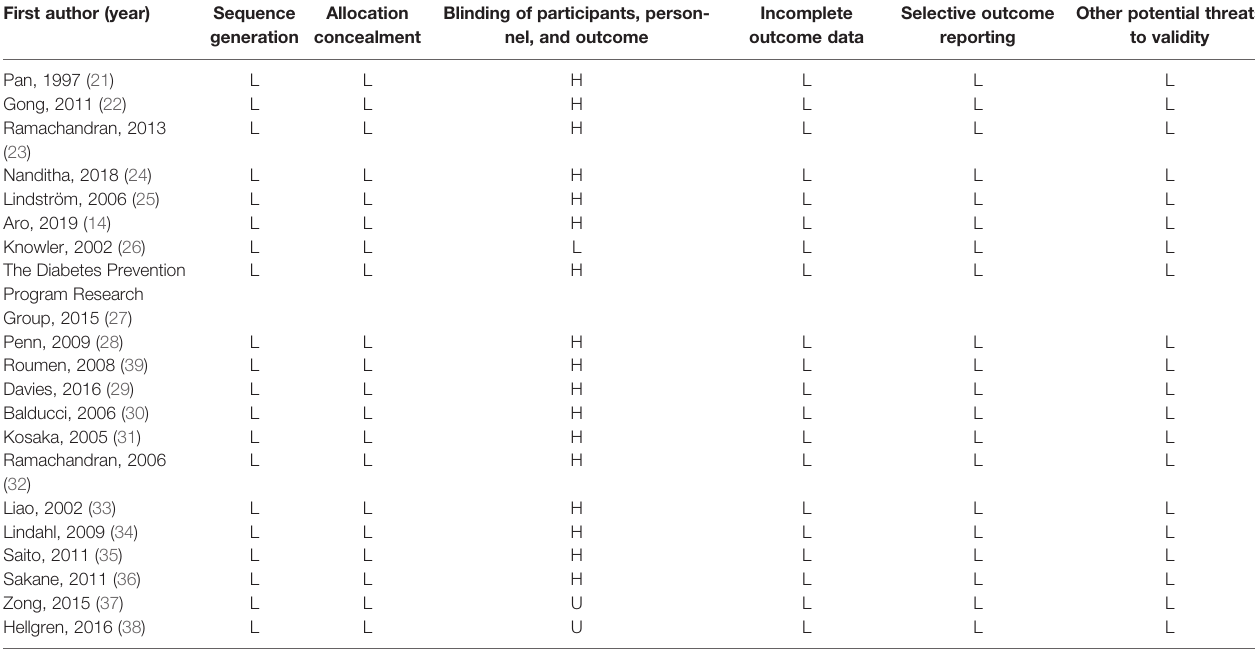
TABLE 4 | Quality of bias assessment of the included studies according to Cochrane guidelines.